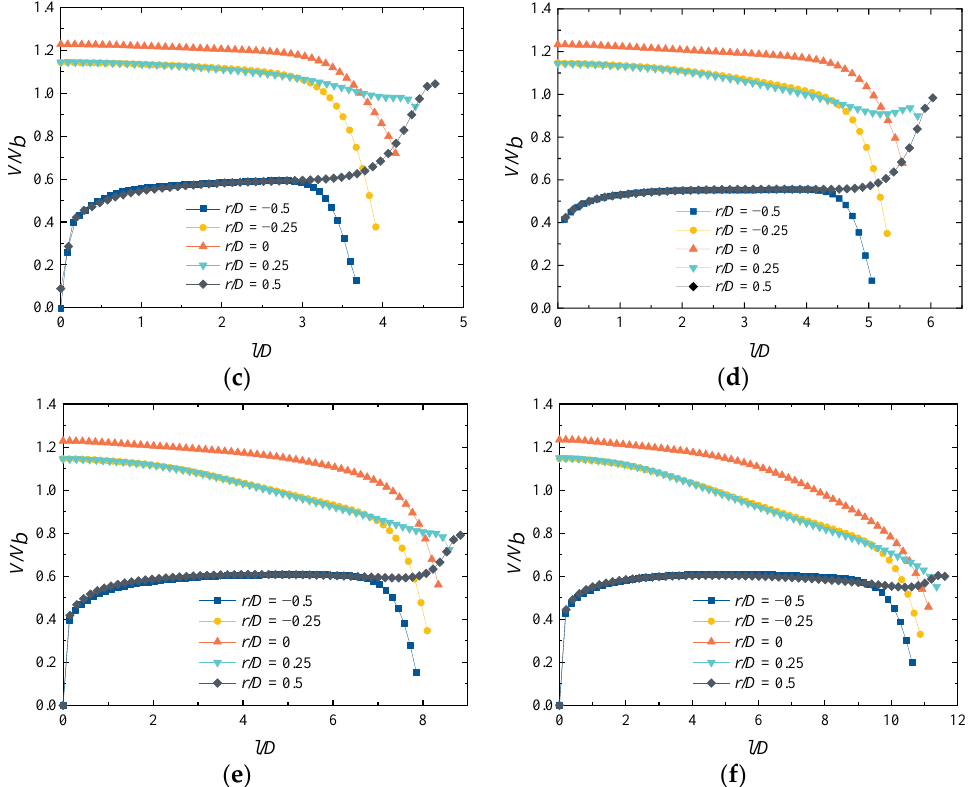
Figure 9. Axial profile development of mean velocity V/V b at different radial locations under various impinging heights: ( a ) H/D = 1; ( b ) H/D = 2; ( c ) H/D = 3; ( d ) H/D = 4; ( e ) H/D = 6; ( f ) H/D = 8. Figure 10 shows the variation law of flow angle ϕ ( Re = 35,100) in each radial direction ( r/D = 0, ±0.25 and ±0.5) of jet under various impinging heights. In the free-jet region, the flow angle ϕ is always close to the impinging angle θ . At this time, the impingement plane has little influence on the flow, and the changes in |V x | and |V z | are basically the same. In the impingement region, the values of ϕ decay linearly with l/D at r/D = 0, ± 0.25, and 0.5, and the decay rates are different at various radial locations. The flow angle ϕ increases gradually at r/D = − 0.5. When H/D = 1, the maximum value of ϕ is greater than 90 ◦ , and there is a countercurrent flow; when H/D ≥ 2, the flow angle ϕ is less than 90 ◦ , indicating that the flow deflects in the downstream direction.